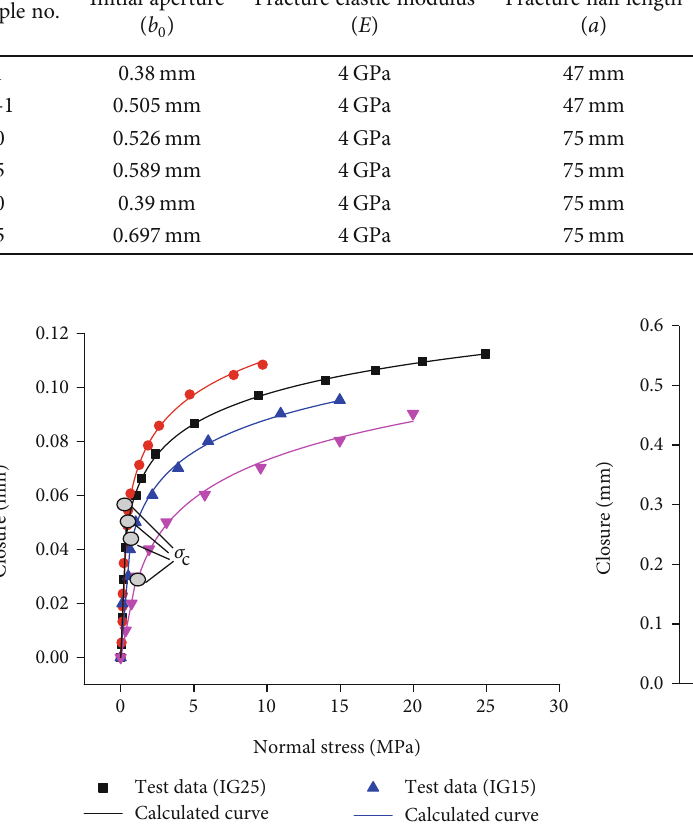
Table 1: Parameter values used for matching the data obtained under normal stress. Sample no.